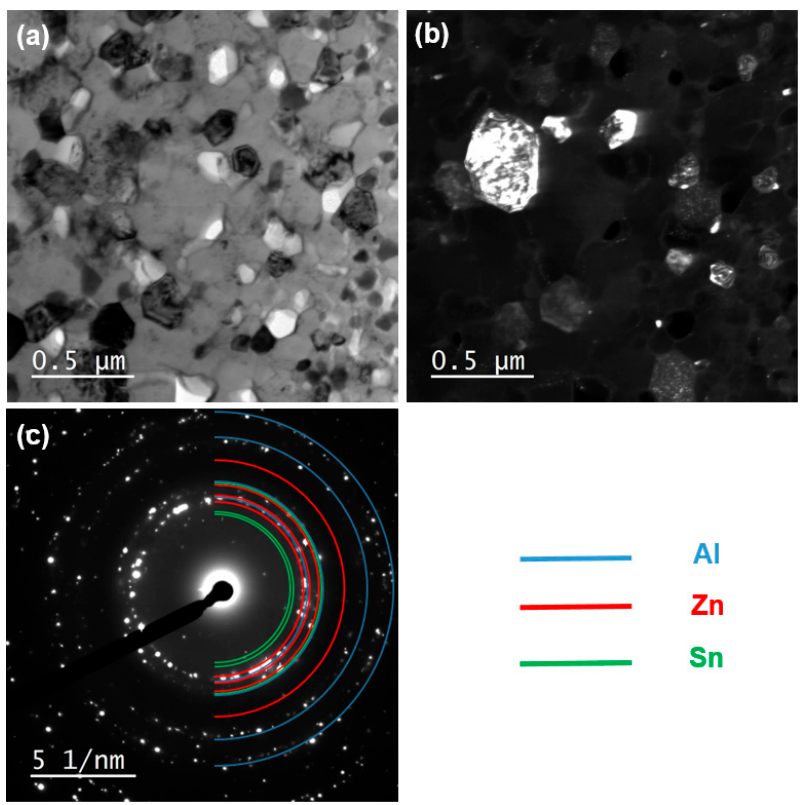
Figure 8. TEM ( a ) bright-field and ( b ) dark-field images including ( c ) corresponding selected-area electron diffraction (SAED) pattern for Al-30wt %Sn-10wt %Zn powders after HPT processing for N = 20.